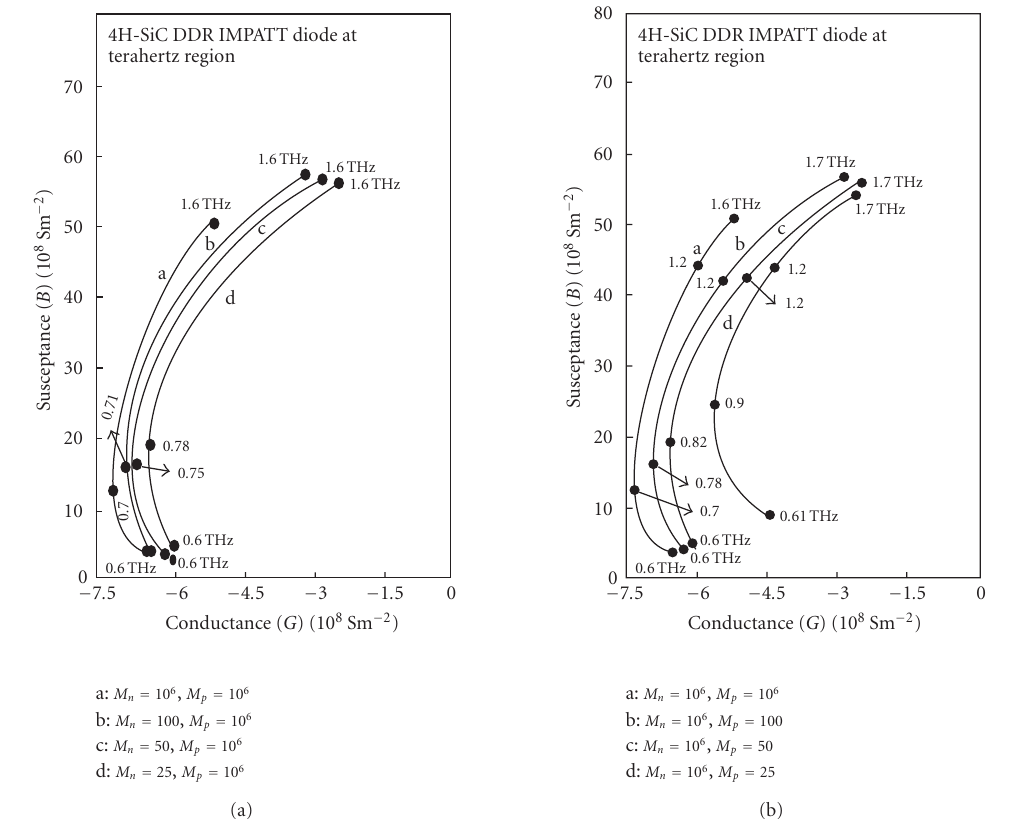
Figure 4: (a) E ff ect of electron dominated photo-current on 4H-SiC DDR IMPATT diode at terahertz region. (b) E ff ect of hole dominated photo-current on 4H-SiC DDR IMPATT diode at terahertz region.